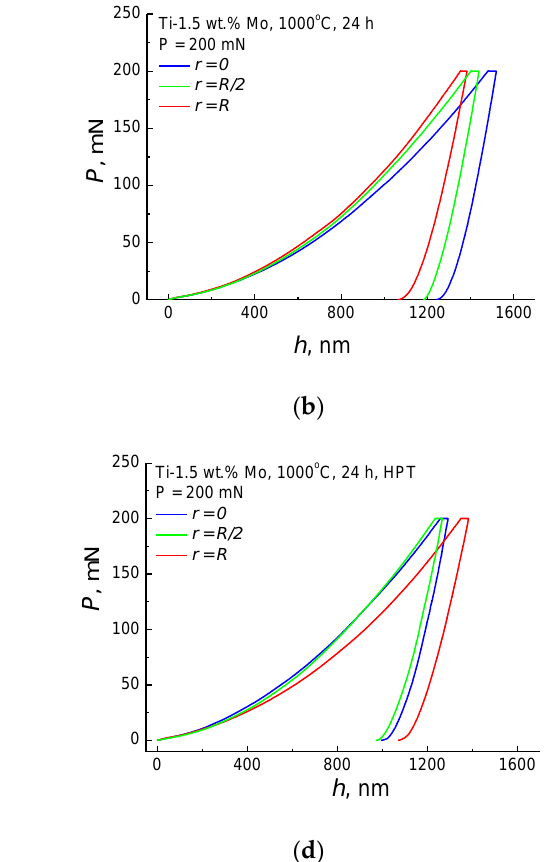
Figure 6. P – h diagrams ( P is the magnitude of the load, h is the depth of the imprint) for the Ti – 1.5 wt.% Mo alloy in the center of the disc ( r = R 0 ), in the middle of radius ( r = R 1/2 ), and at the edge of the sample ( r = R 1 ): ( a , b ) annealed at 1000 °C for 24 h; ( c , d ) annealed and subjected to HPT. Loads ( a , c ) P = 10 mN and ( b , d ) P = 200 mN.